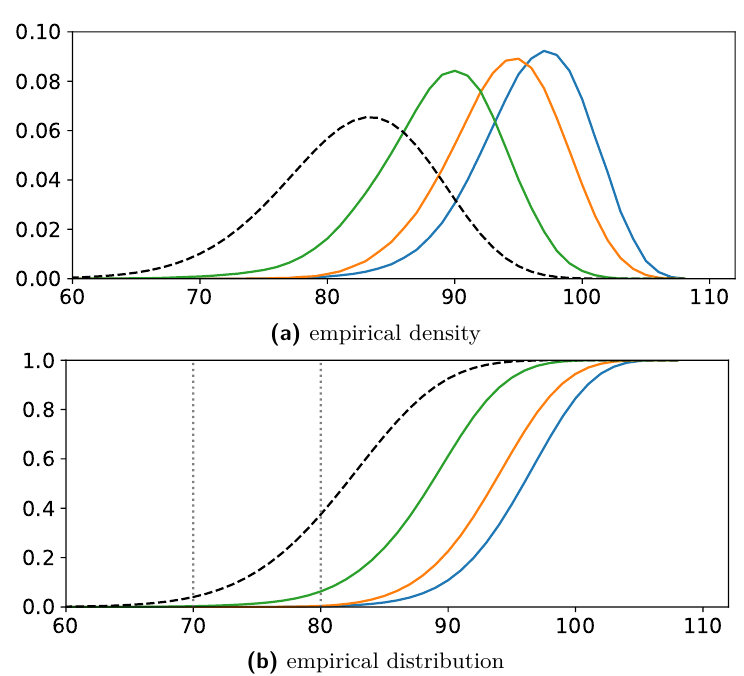
Figure 21: Empirical density and distribution of security levels for an attack against 3-key triple DES (equal to combined attack on two DES keys). Results are shown for attacks on 1 trace (blue), 3 traces (orange) and 900 traces (green). Results obtained from a noise-free simulation are shown (black,